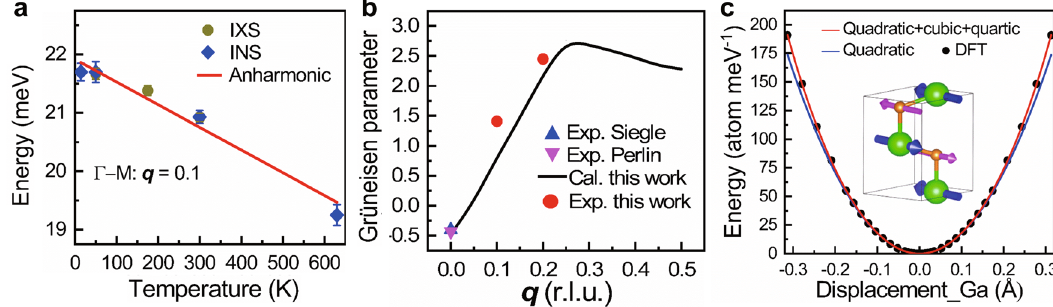
Fig. 5 Anharmonicity of the optical mode in the higher nested branch (Arc) at momentum q = 0.1 along Γ ‒ M in α -GaN. a Temperature dependence of phonon energy. Data were obtained from both inelastic X-ray scattering (IXS) and inelastic neutron scattering (INS) measurements. The lines show the fi tting of the data points by Eq. (2). The error bars are the uncertainties of a least-squares fi tting result from the damped-harmonic-oscillator model. b The experimental (Exp.) mode Grüneisen parameters of the phonon modes on the Arc branch, compared with the fi rst principles calculations (Cal.) along Γ ‒ M. The blue triangle and the pink inverted triangle are the data from the Raman measurements reported by Siegle et al. 51 and Perlin et al. 52 respectively. c The frozen phonon potential of the Arc at q = 0.1 along Γ ‒ M corresponding to the displacement of Ga along b -axis. Inset indicates the corresponding vibration mode, where the green balls represent Ga atoms and orange balls represent N atoms. The vectors indicate the direction of the displacement of the corresponding